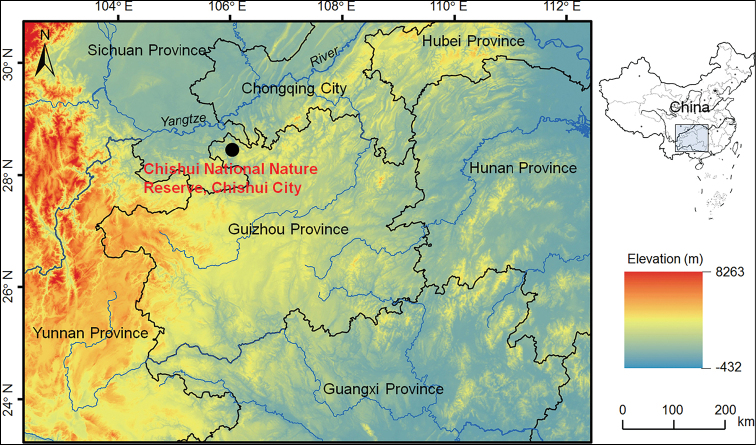
Geographical location of the type locality, Chishui National Nature Reserve, Chishui City, Guizhou Province, China, of Megophrys
chishuiensis sp. nov.